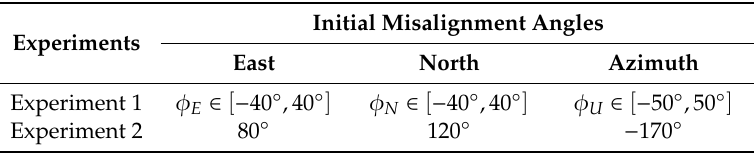
Table 5. Settings of experiment